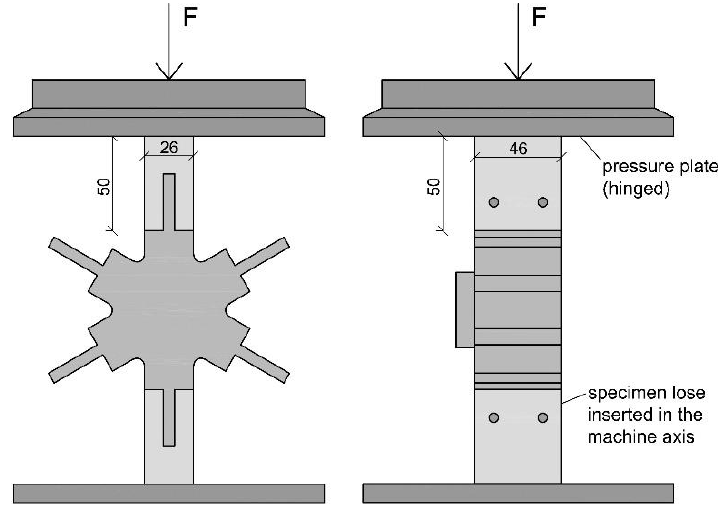
Figure 5. Test setup of the compression tests.